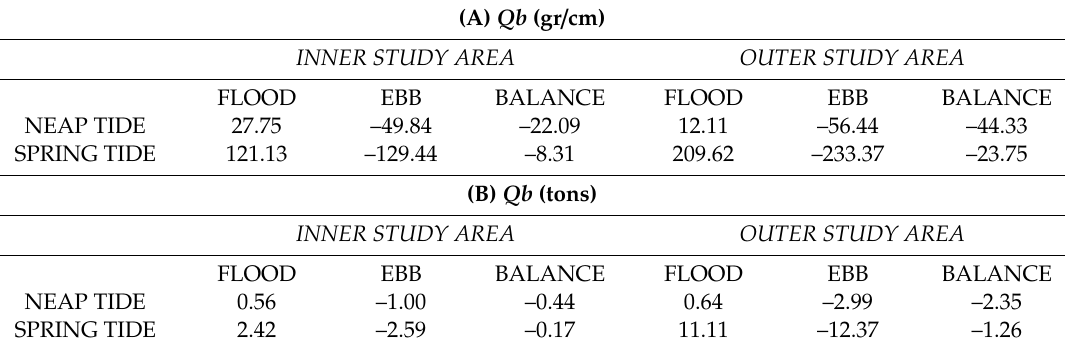
Table 1. Potential bedload transport ( Qb ) for complete tidal semicycles. ( a ) Values obtained by application of Bagnold’s equation (expressed in g / cm). ( b ) Values obtained for the complete flow section (expressed in